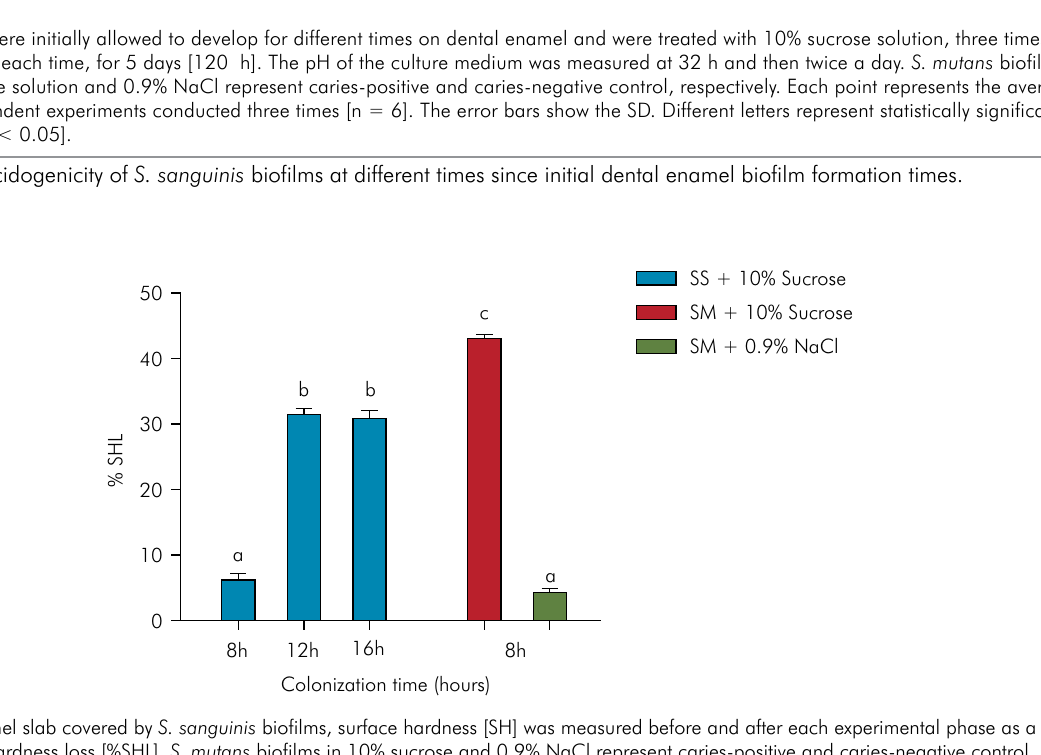
Figure 2. Demineralization of dental enamel after the formation of S. sanguinis biofilms at different times since initial biofilm